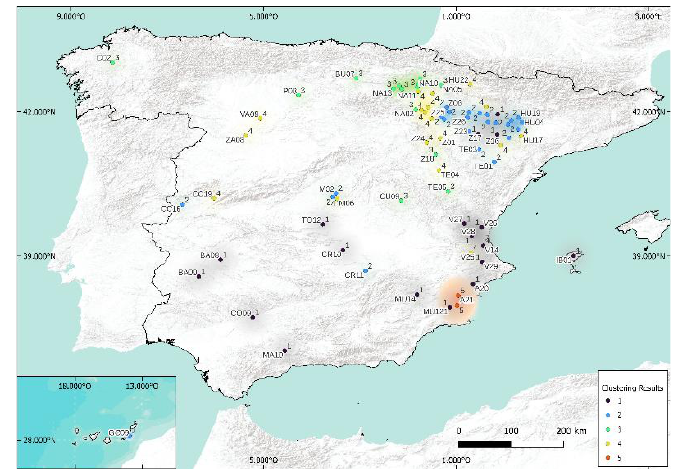
Figure 13. Using k-medoids for 5 clusters.